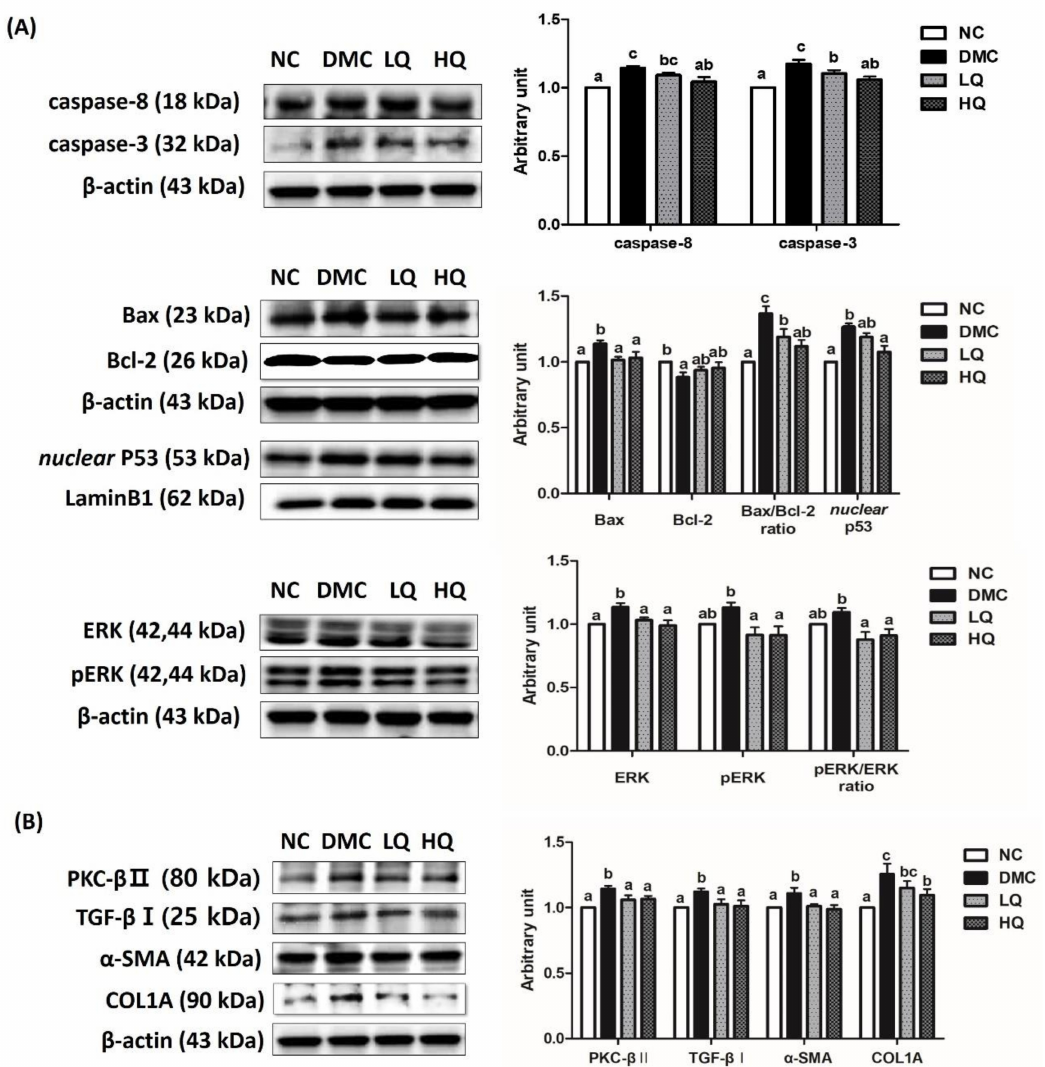
Figure 6. E ff ect of QAE on renal ( A ) apoptosis and ( B ) fibrosis in T2DM mice. Data were expressed as means ± SEM. Mean values with the same superscript letter (a,b and c) are not significantly di ff erent ( p < 0.05). NC: Normal mice; DMC: Type 2 diabetic mice; LQ: Type 2 diabetic mice supplemented with a low dose (5 mg / kg / day) of QAE; HQ: Type 2 diabetic mice supplemented with a high dose (10 mg / kg / day) of